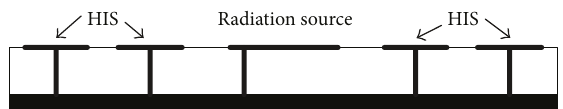
Figure 2: The schematic diagram of a microstrip antenna with HIS structures.